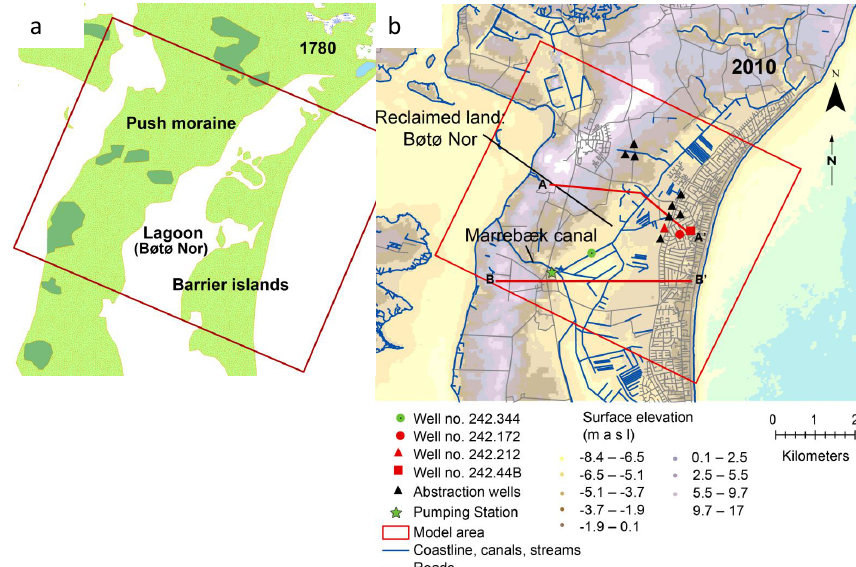
Fig. 2. Illustration of the development of the study area between 1780 and 2010. The drainage of the lagoon was initiated in 1860. The red lines A–A 0 and B–B 0 indicate the locations of the cross sections shown in Fig. 3. Well no. 242.44B is located at Marielyst Waterworks. Marielyst is the summer residence area along the eastern coastline.